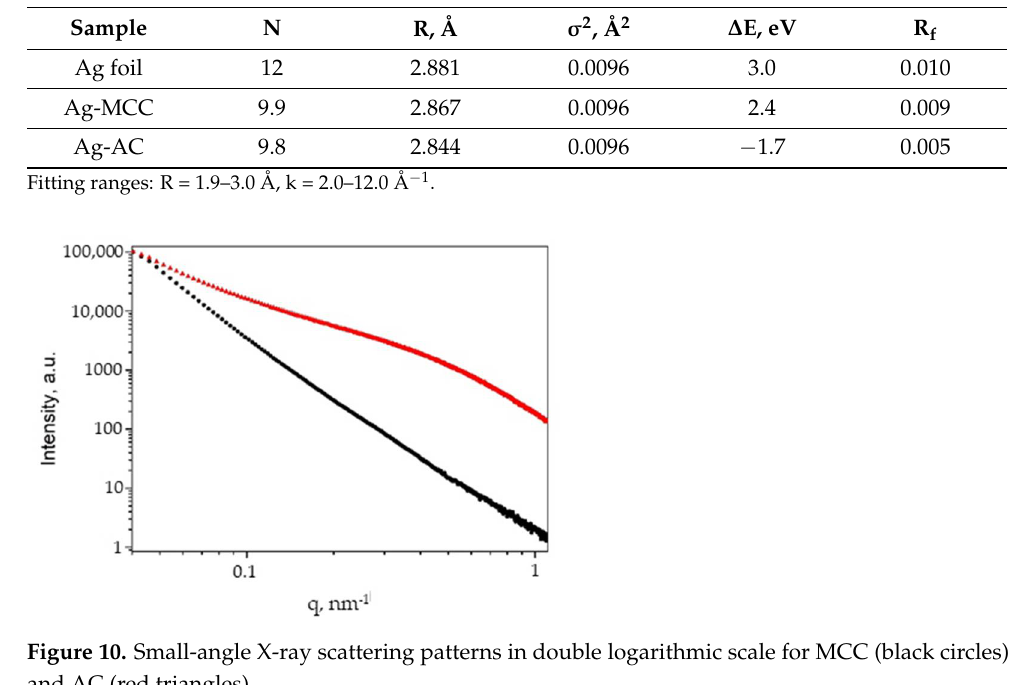
Figure 10. Small-angle X-ray scattering patterns in double logarithmic scale for MCC (black cir- cles) and AC (red triangles).